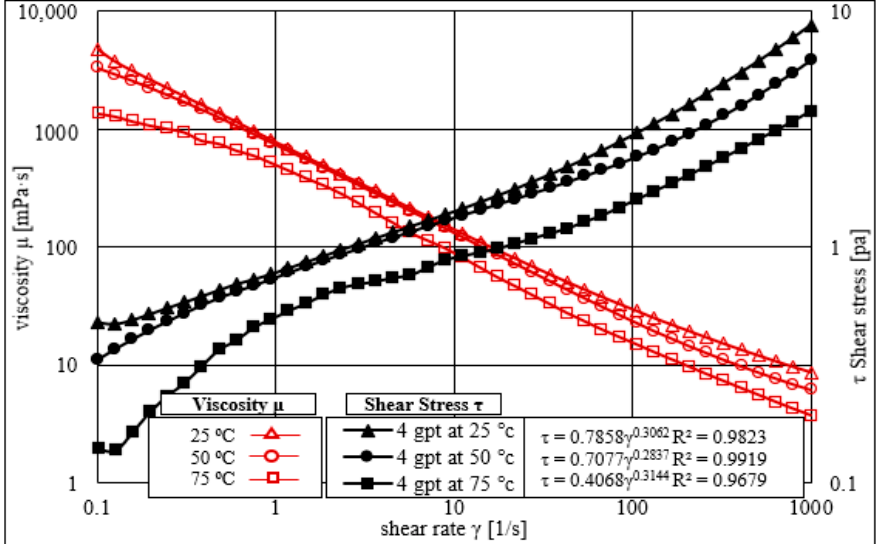
Figure 5. Flow curves and viscosity curves for the HVFR measured at various temperatures.